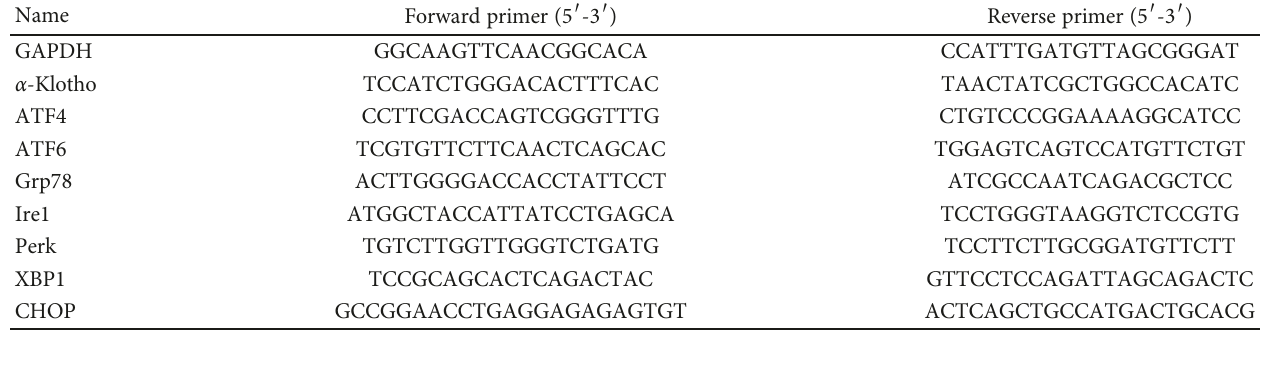
Table 1: Sequence of primer pairs for qPCR.